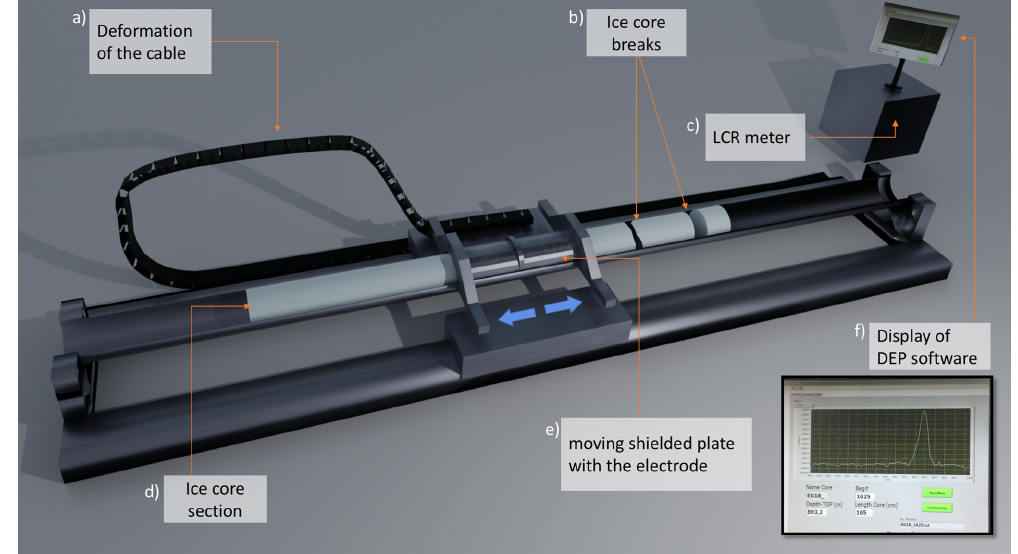
Figure 4. Schematic of the DEP instrument.